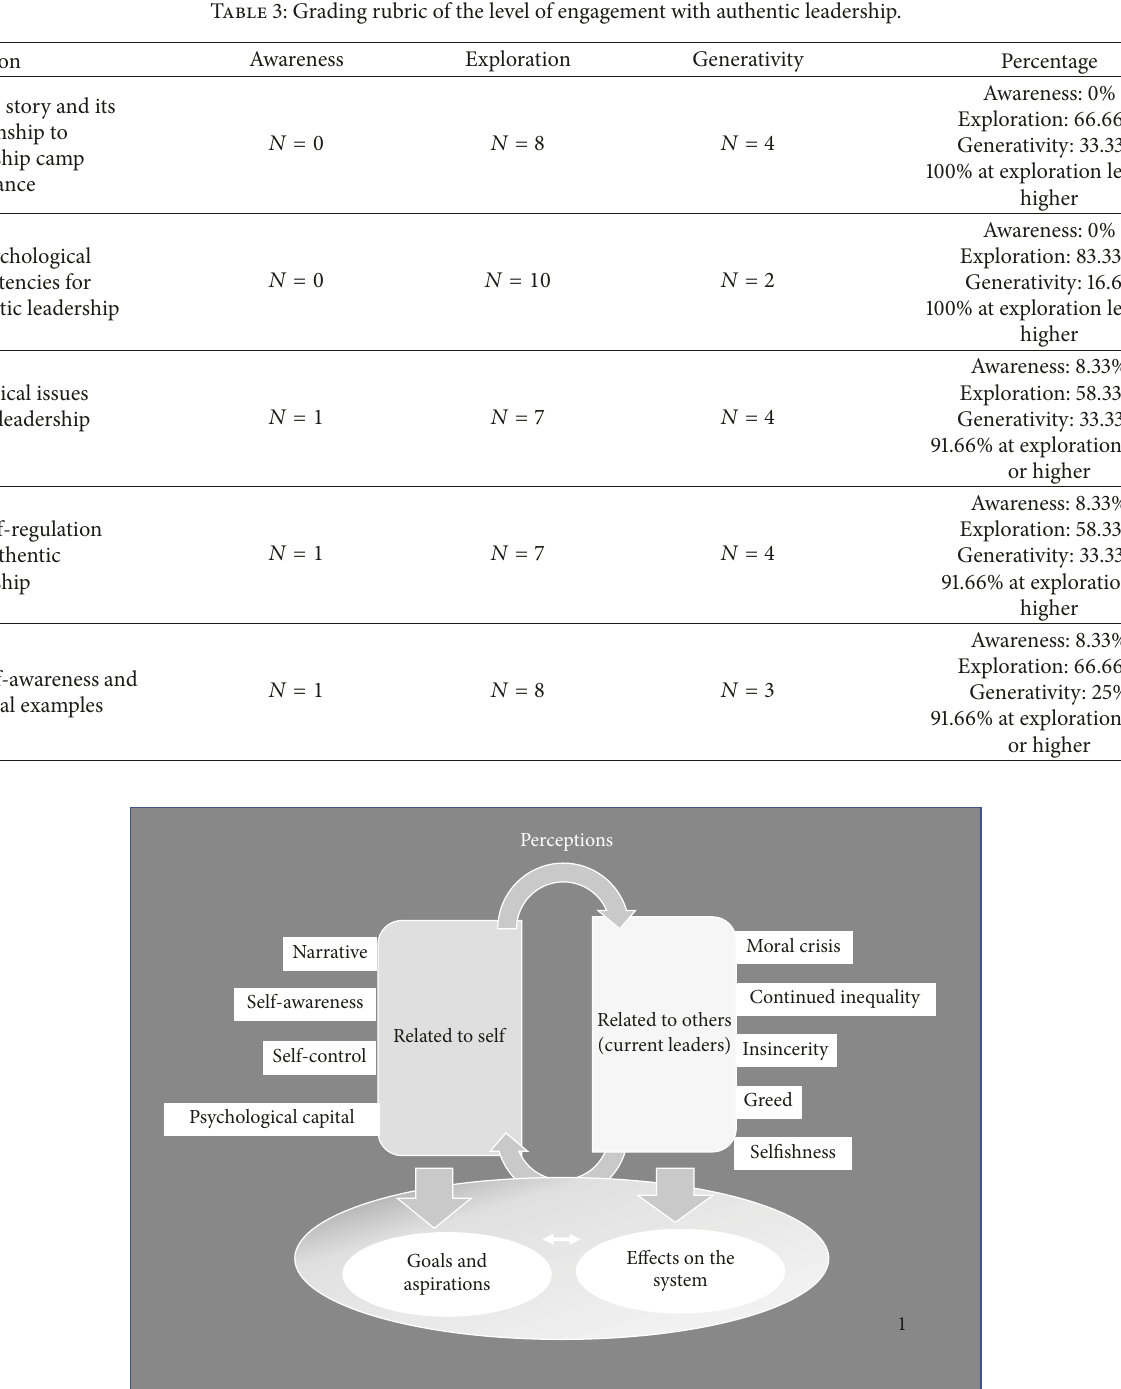
Figure 1: Student perceptions of authentic leadership